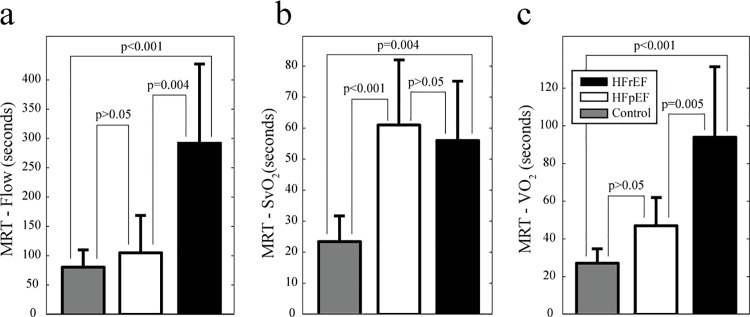
Mean response times.Mean response times (MRT) for (a) muscle blood flow, (b) SvO2 and (c) VO2 following knee-extension exercise. Control data from a previous study using an identical acquisition protocol [16].